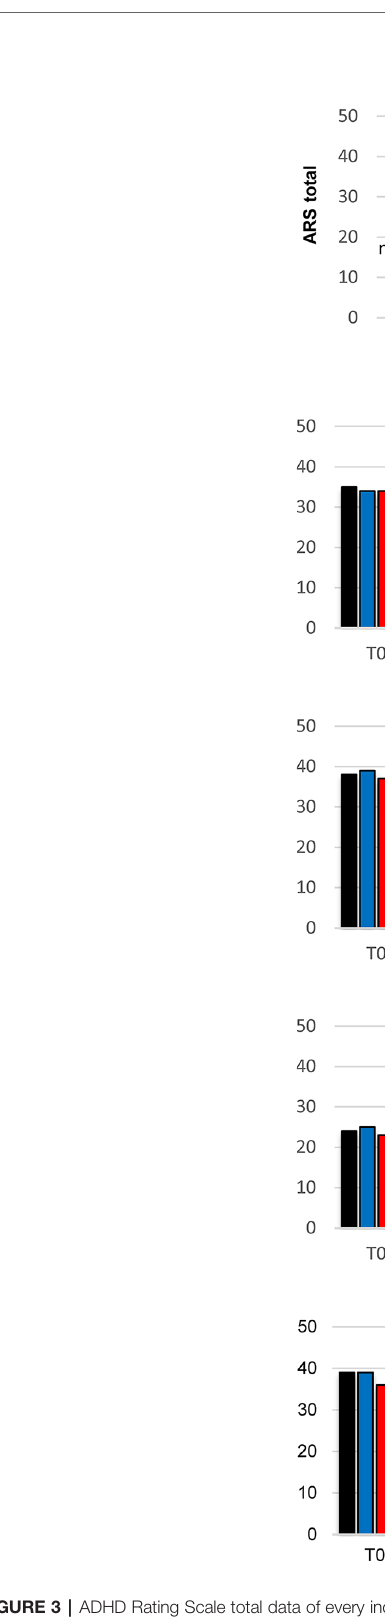
FIGURE 3 | ADHD Rating Scale total data of every individual participant in the study at the appointments T0, T1 and T2 (n = 10), results for the 4 independent raters. Blue bar: non-blinded rater, red bar: video rater 1, green bar: video rater 2, yellow bar: video rater